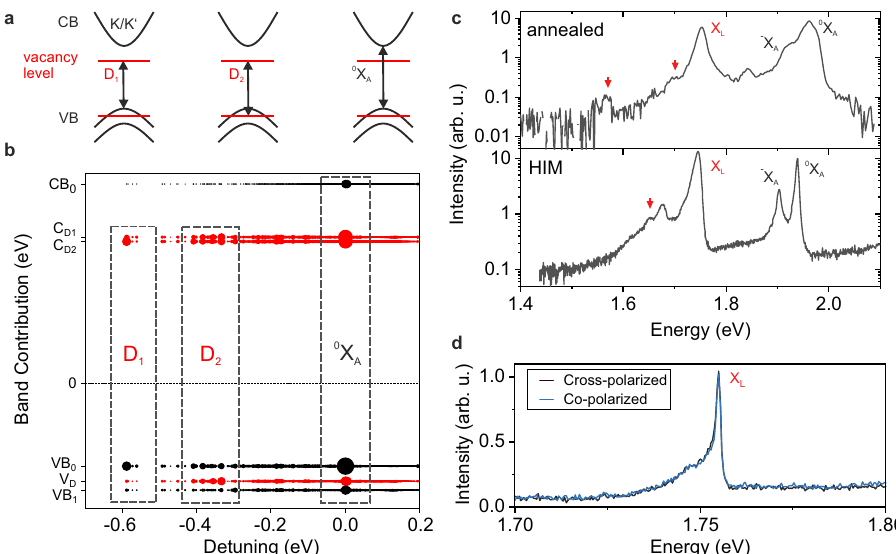
Fig. 4 Defect bound excitons in monolayer MoS 2 . a Quasiparticle conduction (CB) and valence (VB) bands (black) near K-points and K ′ -points in the Brillouin zone of single-layer MoS 2 . The red lines denote states arising from sulfur vacancy levels. Arrows highlight the three types of excitonic transitions: between the delocalized bands ( 0 X A ), between the localized defect states only (D 2 ) and between the valence band and the localized defect state (D 1 ). b Band contribution to exciton transitions computed with GW-BSE. Dot size represents the relative oscillator strength, and the probability amplitudes of the occupied and empty bands contributing to it. Black indicates delocalized band states and red indicates localized defect states. CB 0 and VB 0 , VB 1 denote the dispersive unoccupied conduction and occupied valence bands (above and below the Fermi level), respectively. C D1 and C D2 are unoccupied localized defect levels, split by spin – orbit interaction arising from conduction band states. V D is the occupied localized defect level arising from the valence band. The three main peaks regions assigned with the D 1, D 2 , and 0 X A transitions are marked with dashed lines. c PL spectra of annealed and HIM-treated MoS 2 . The defect emissions occur in a range of 0.2 – 0.3 eV below X A with a dominant emission line (X L ) around 1.75 eV. Further features (red arrows) are resolved at even larger detuning from the free exciton, in qualitative agreement with the predicted continuum of excitonic defect states below the pristine optical gap. d A single He-ion induced emitter shows no detectable valley polarization ( T = 10 K, excitation energy 2.1 eV) as expected for transitions involving only defect levels (D 2